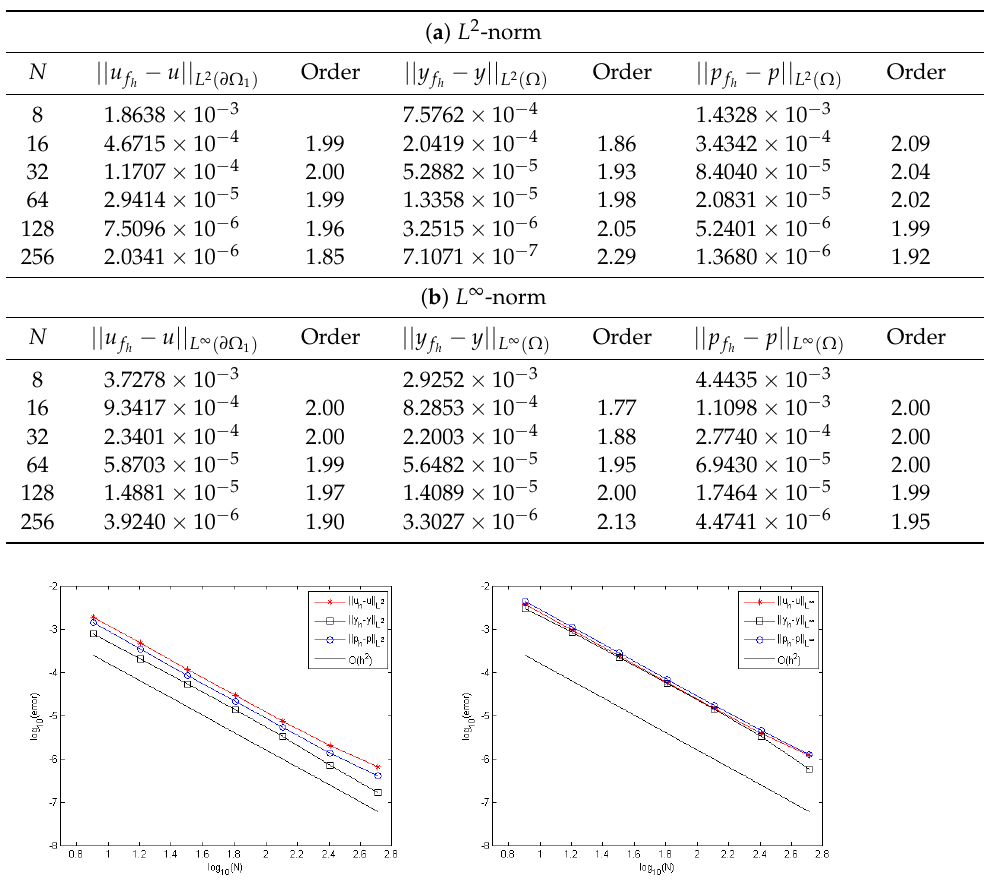
Figure 7. Convergence orders of u f